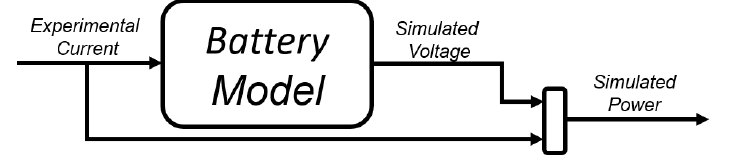
Figure 11. Battery model I/O scheme.